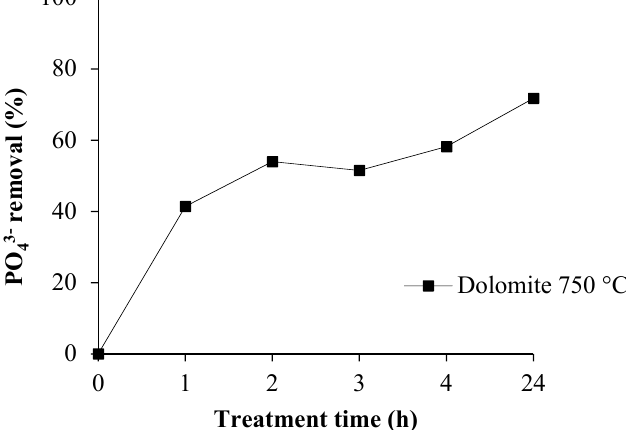
Figure 9 . Phosphate removal percentages of dolomite 750 °C (Mg:P:N molar ratios 1.3:1:1) from agricultural sludge.